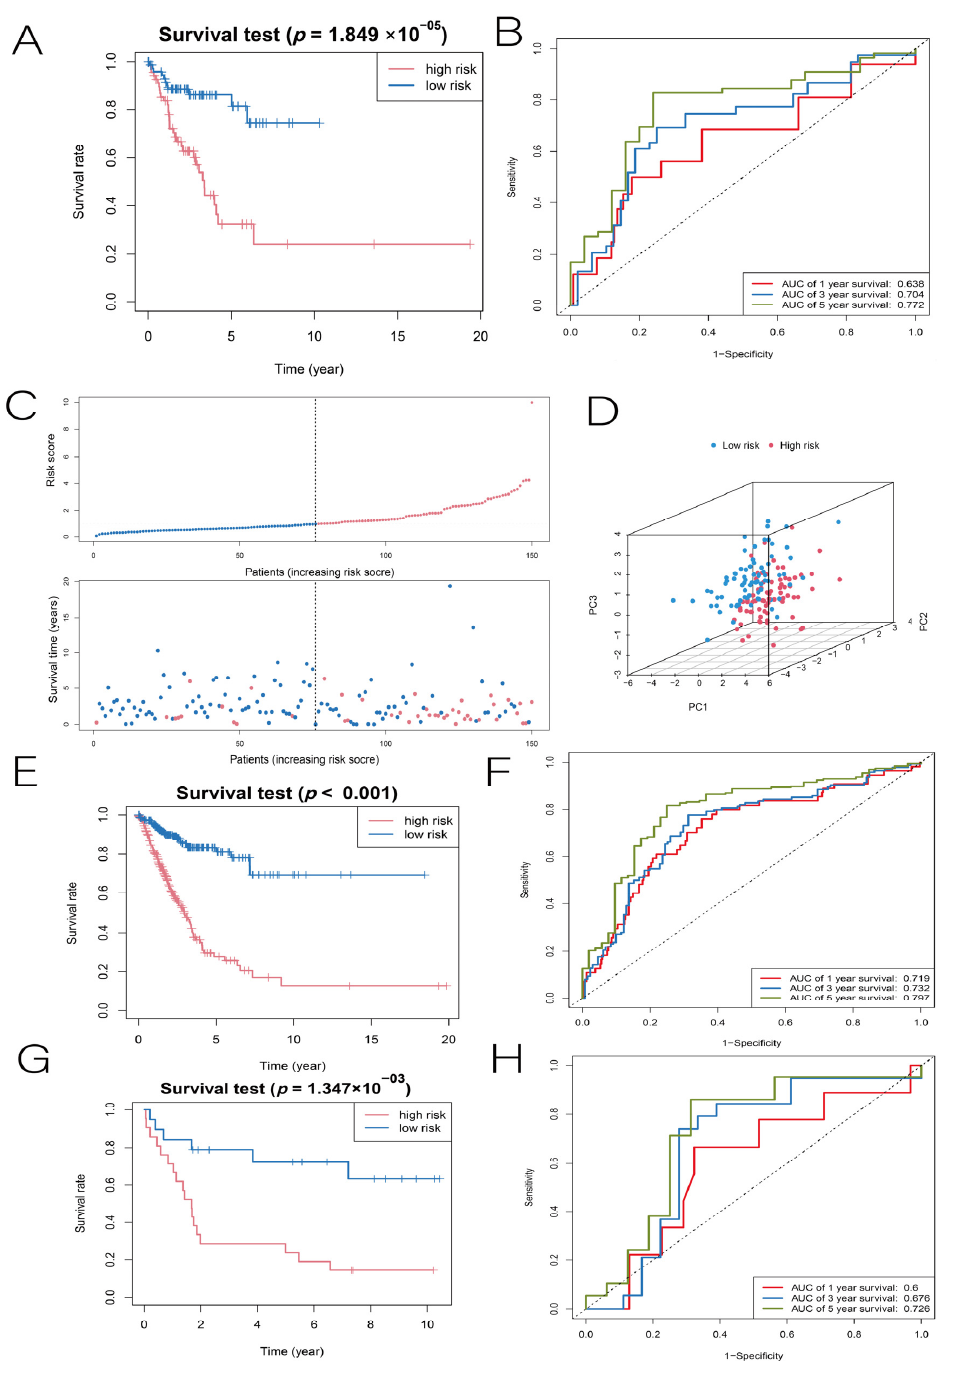
Figure 5. ( A ) In the internal test set, K-M plots of OS for patients in the high-risk and low-risk groups. ( B ) ROC curves for the internal test group with 1-year, 3-year, and 5-year OS. ( C , D ) Risk survival status maps and PCA distribution maps for the internal test group. ( E , F ) K-M plots of OS for patients in the high-risk and low-risk groups when the complete TCGA set was performed as a test set, and ROC curves for 1-year, 3-year, and 5-year OS. ( G , H ) K-M plots of OS for patients in the high-risk and low-risk groups when the GSE19188 chip was used for the test set, and ROC curves of OS at 1, 3, and 5